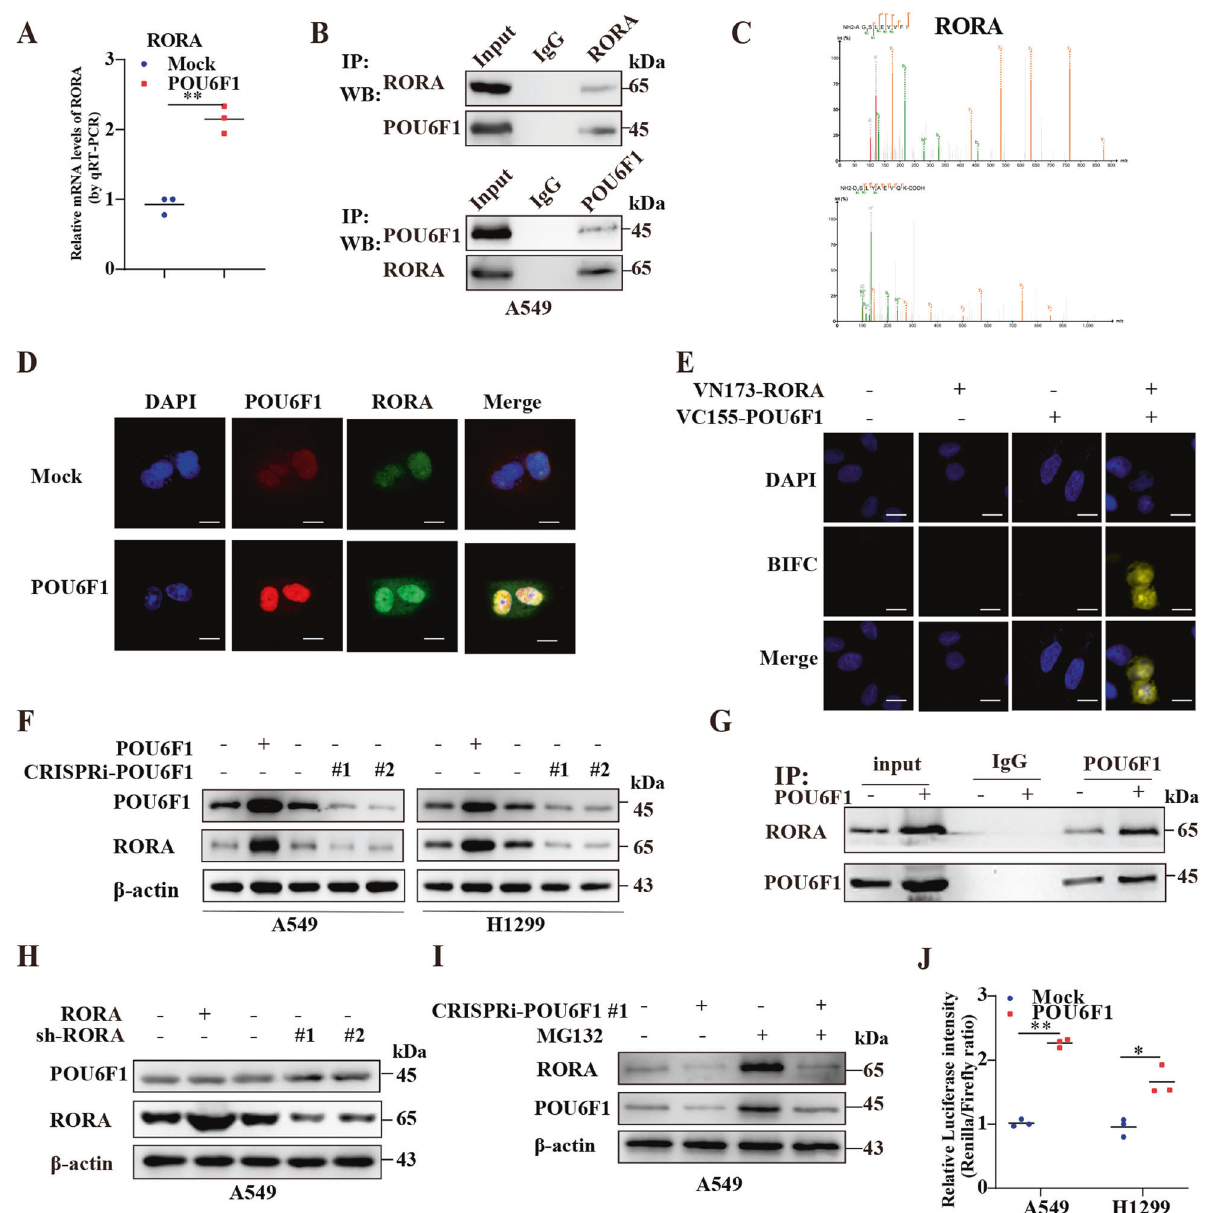
Fig. 6 POU6F1 binds RORA and enhances the stabilization and activity of RORA. A Real-time qRT-PCR assay indicating the expression of RORA in A549 cells stably transfected with empty vector (mock) or POU6F1. B Co-IP and western blotting assays indicating the endogenous interaction between POU6F1 and RORA in A549 cells. The immunoglobulin G (IgG)-bound protein was taken as the negative control. C Mass spectrometry detection showing the spectrogram of RORA in A549 and HEK293T cells pulled down by POU6F1 antibody. D Immuno fl uorescence assay con fi rming the colocalization of POU6F1 and RORA in A549 cells transfected with empty vector (pCMV-HA) or pCMV-HA-POU6F1. Scale bars:10 µm. E Confocal images of BiFC showing the direct visualization of POU6F1 and RORA in A549 cells co- transfected with pBiFC-VC155-POU6F1 and pBiFC-VN173-RORA. Scale bars:10 µm. F Western blotting assay showing the expression of RORA in A549 and NCI-H1299 cells transfected with mock, POU6F1, CRISPRi-Scb, CRISPRi-POU6F1 #1, or CRISPRi-POU6F1 #1. G Co-IP and western blotting assays indicating the interaction between POU6F1 and RORA in A549 cells transfected with mock or POU6F1. H Western blotting assay showing the expression of POU6F1 and RORA in A549 cells transfected with mock, RORA, scramble shRNA (sh-Scb), sh-RORA #1, or sh- RORA #2. I Western blotting assay showing the expression of RORA in A549 cells transfected with CRISPRi-Scb or CRISPRi-POU6F1 #1, and those treated with MG132 (5 μ mol/l) for 6 h. J Dual-luciferase assay indicating relative promoter activity of RORA in A549 and NCI-H1299 cells transfected with mock or POU6F1. Student t -test compared the difference in A and J . * P < 0.05, ** P < 0.01. stability, and enhanced its transcriptional activity [44]. In this study, HIF1A transcriptional activity. It has been previously reported that we found that POU6F1 promoted HIF1A ubiquitination and HIF1A plays an essential role in cellular proliferation and angiogen- degradation in LUAD cells. HIF1A directly transactivates various esis by regulating the transcription of diverse genes, such as VEGF genes, such as PDK1 [33]. In this study, we demonstrated that and PD-L1 [40, 41]. HIF1A stabilization can be regulated by a wide POU6F1 enriched on the promoter of genes ENO1, PDK1, and array of regulators [42, 43]. For example, the small ubiquitin-like PRKCB, and affected the luciferase activities of three genes. But modi fi er-1 was co-immunoprecipitated with HIF1A, increased HIF1A Cell Death and Disease (2022)